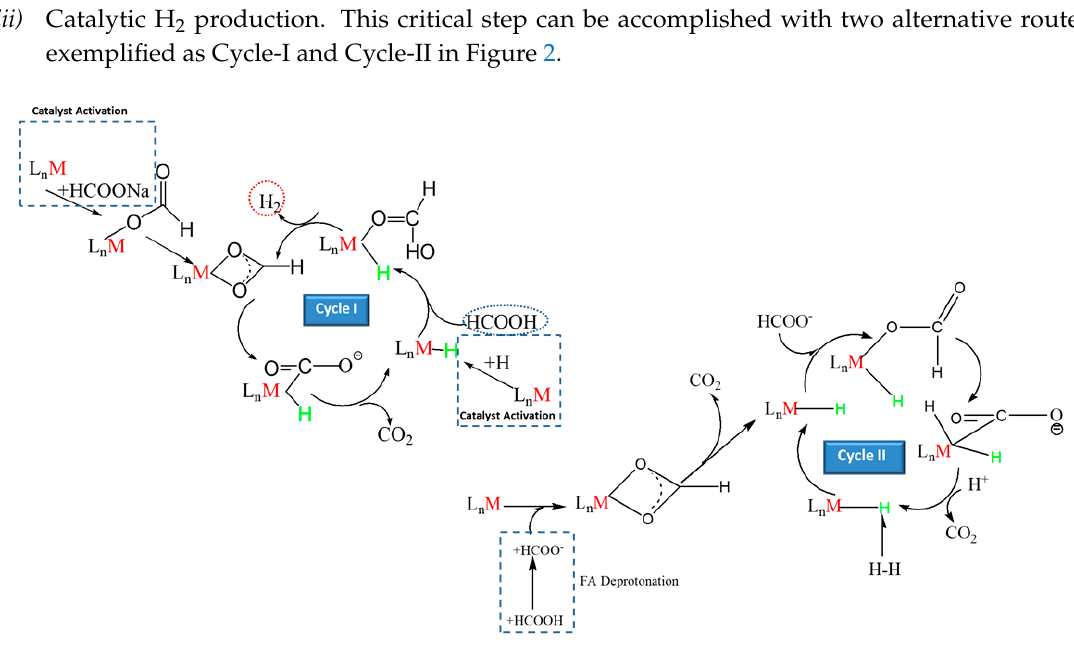
Figure 2. General catalytic landscape of FA dehydrogenation by metal-complex catalyst in solution.